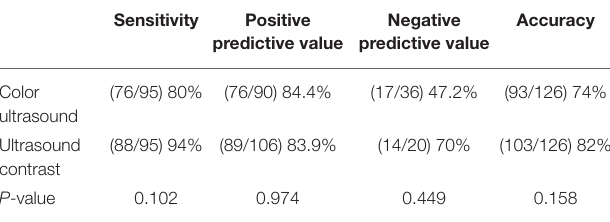
TABLE 3 | Diagnosis by color ultrasound and contrast-enhanced ultrasonography.